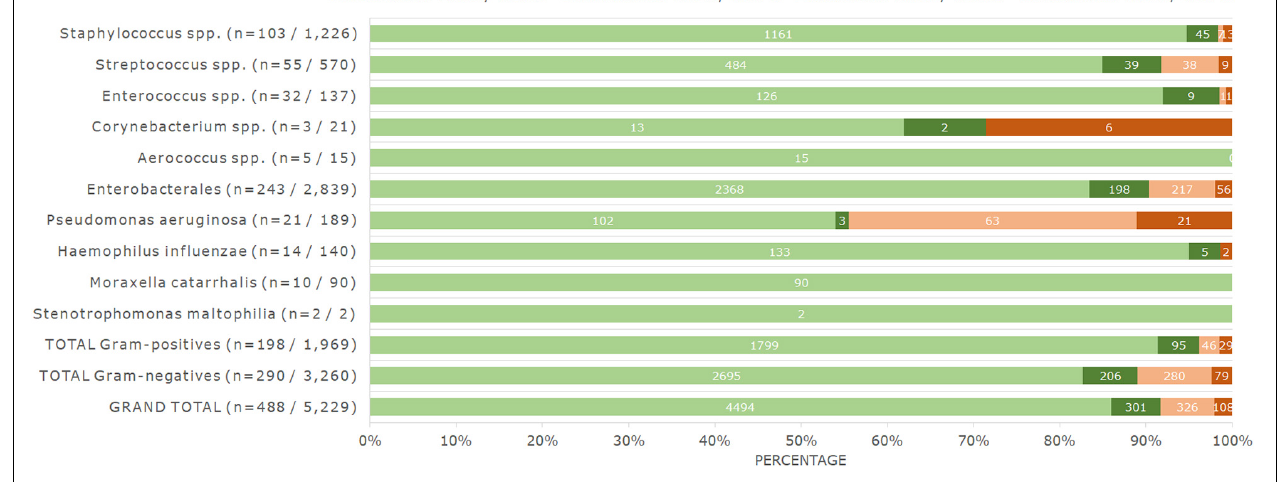
FIGURE 2 | Percentage and number of genotype–phenotype concordances and discordances observed for all bacteria analyzed in this study, when comparing MIC and WGS results. Numbers in brackets for each taxon correspond to the number of isolates, and to the number of isolate-antimicrobial combinations tested. Numbers on top of the bars correspond to the respective number of results. MIC-S cases correspond to S and I phenotypes according to EUCAST clinical breakpoints v12.0, and MIC-R cases correspond to R phenotypes according to the same guideline. WGS-S correspond to cases where no acquired ARGs nor chromosomal PMs have been detected, and WGS-R correspond to cases where they